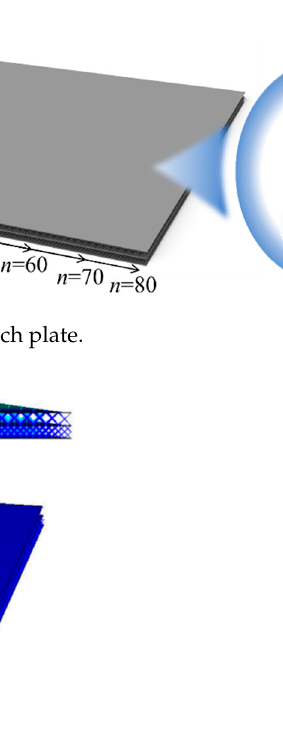
( d ) ( e ) Figure 9. Shear stiffness coefficients in K by S-NIAH and ratio K 11 / D 4 11 ( D 4 22 ) versus various unit cell parameters ( h , t , t m , r 1 , and r 2 ): ( a ) lattice height h , ( b ) upper and lower bound plate thickness t , ( c ) inner plate thickness t m , ( d ) radii of robs in spare layer r 1 , and ( e ) radii of robs in dense layer r 2 . 3.2. Bi-Layer Lattice-Filled Sandwich Plate 3.2.1. Deformation Analysis of Bi-Layer Lattice-Filled Sandwich Plate